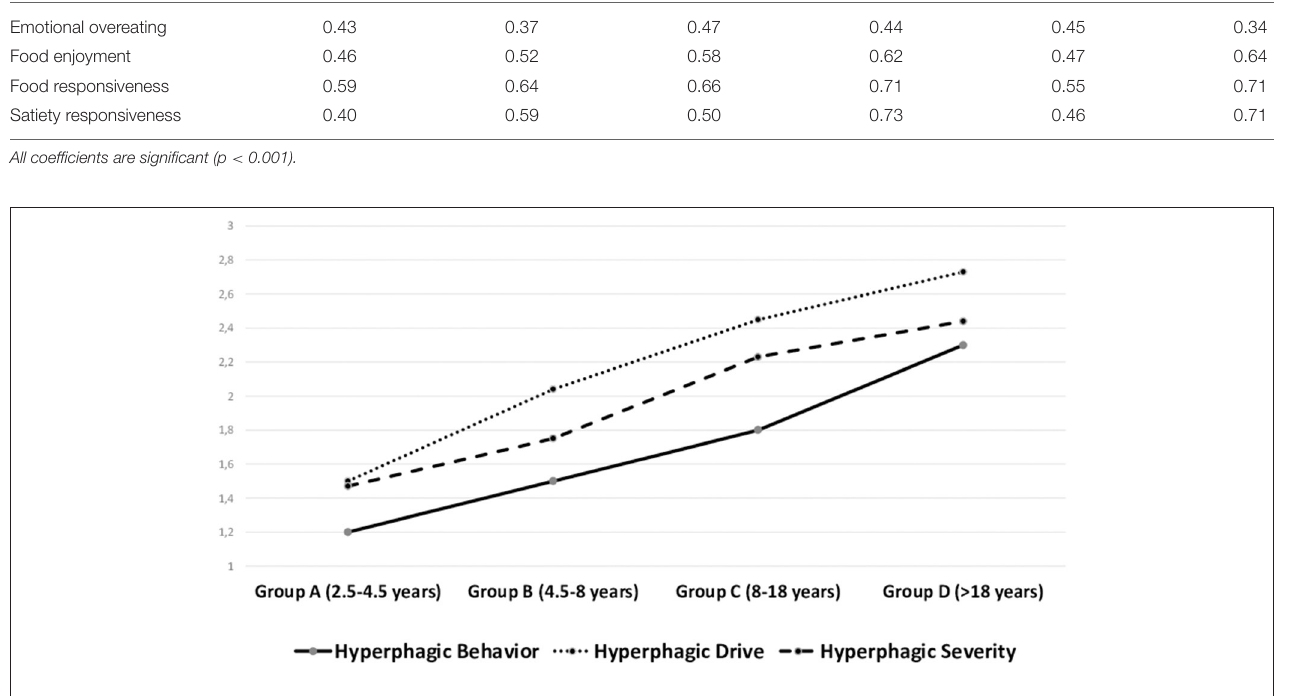
FIGURE 2 | Comparisons of hyperphagia subdimensions by age-group. Values on the Y-Axis express the mean values of each